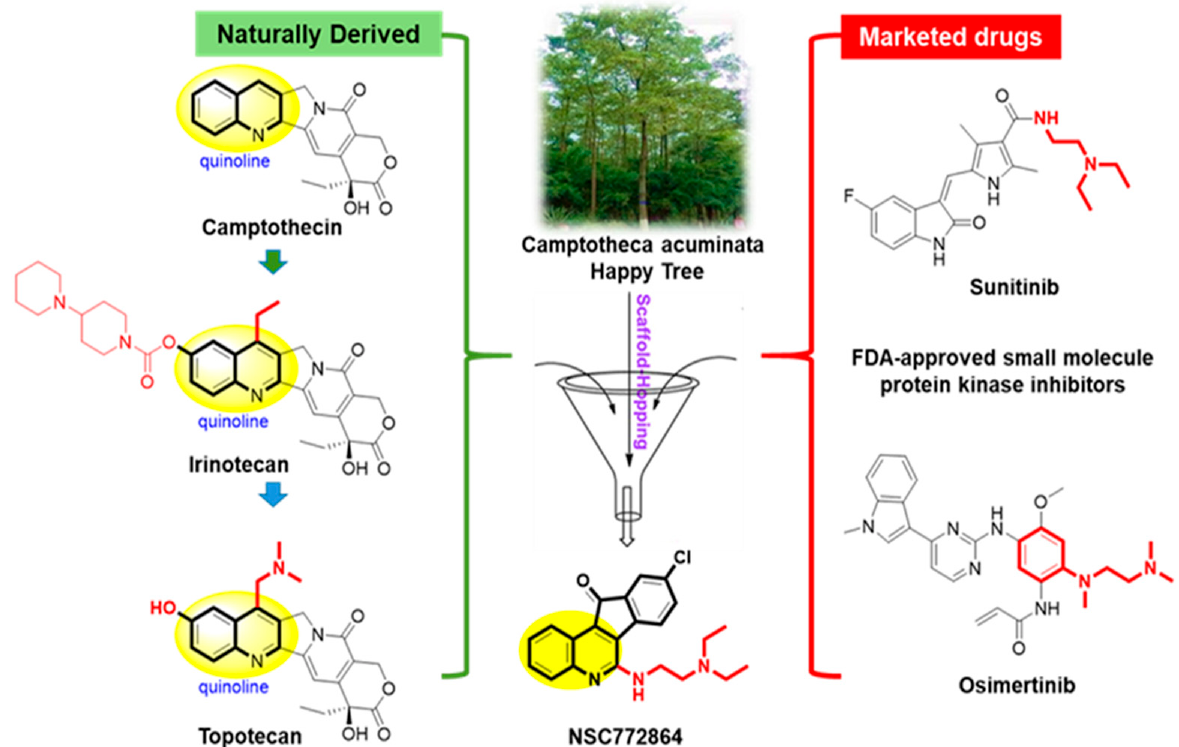
Figure 7. Rational scaffold-hopping protocol for the design of NSC772684. 3.6. c-Met, MYC, and CCND1 Are Potential Drug Targets of NSC772864